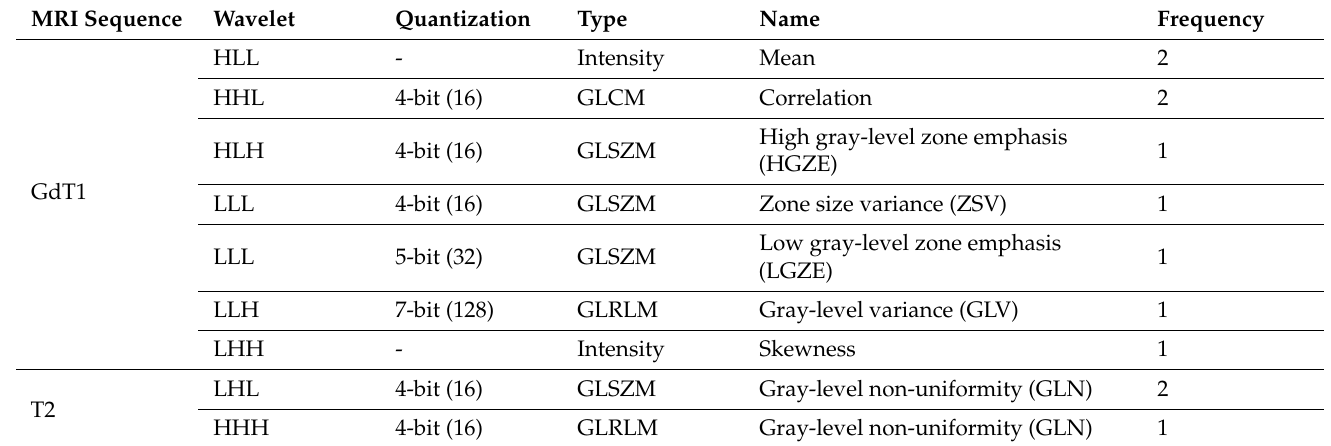
Table 2. Selected features for machine learning models.